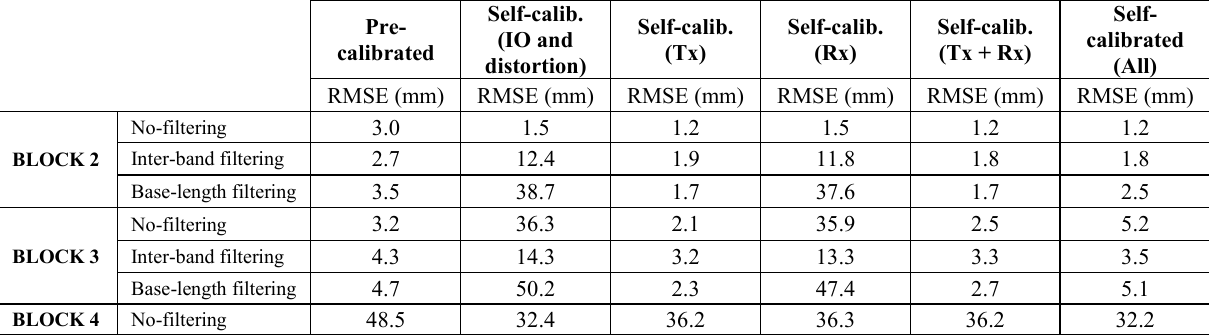
Table 2 . RMSE (in mm) of the residuals of the